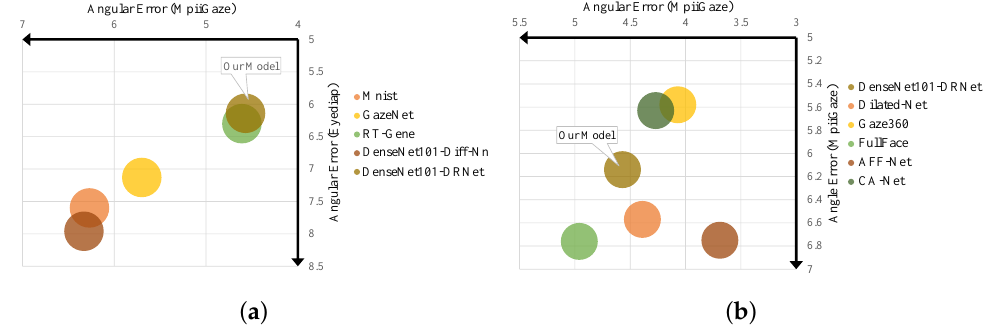
Figure 8. Performance ( angular-error ) of methods that use ( a ) eye features or ( b ) combined eye and facial features. The horizontal axis records the error in the MpiiGaze dataset and the vertical axis records the error in the Eyediap dataset. The model closest to the upper right corner represents better